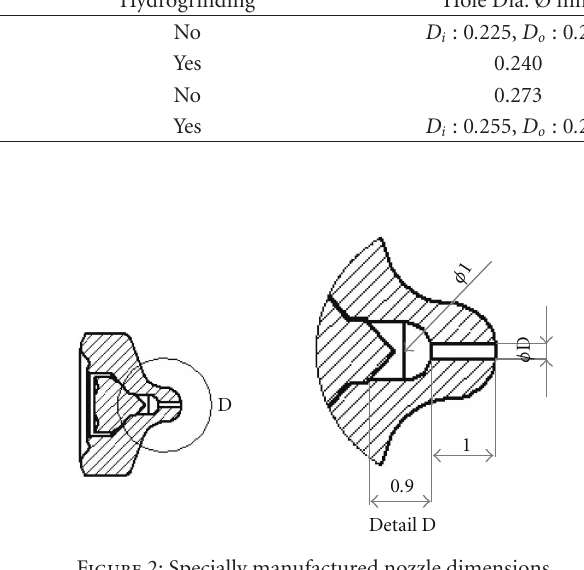
Figure 2: Specially manufactured nozzle